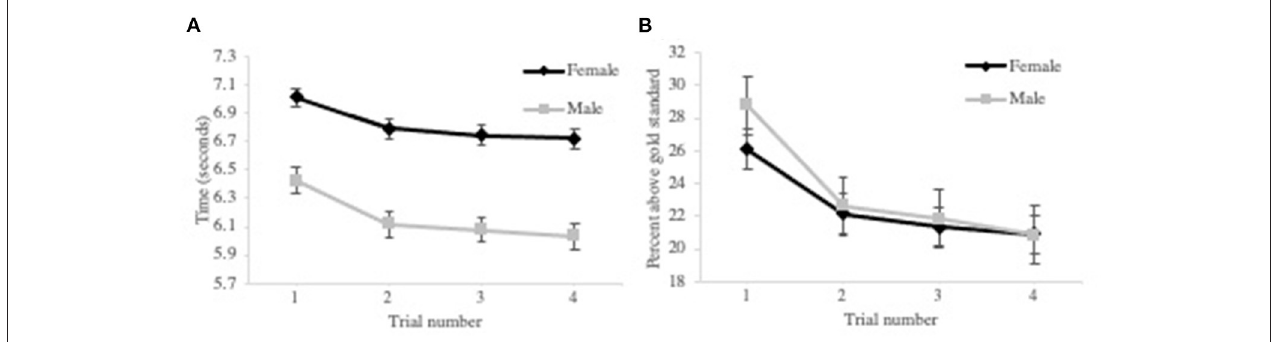
FIGURE 2 | See effect on Phase II participants sprint time. Graph (A) represents the original sex-specific mean for each sprint time trial. Graph (B) represents the sex-specific sprint time mean expressed as the difference between the subject’s sprint time and the gold standard as a percent of the gold standard obtained from the participants for each sprint time trial.